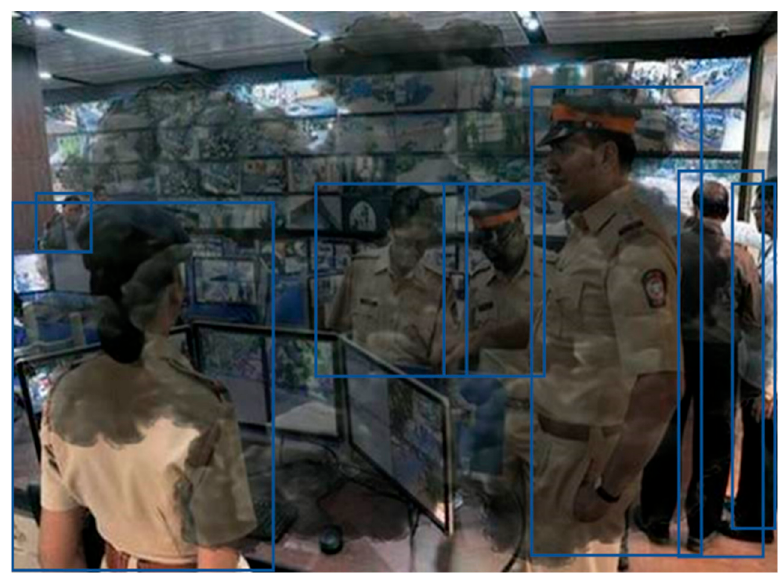
Figure 11. Image showing results of secondary detection using RetinaNet.